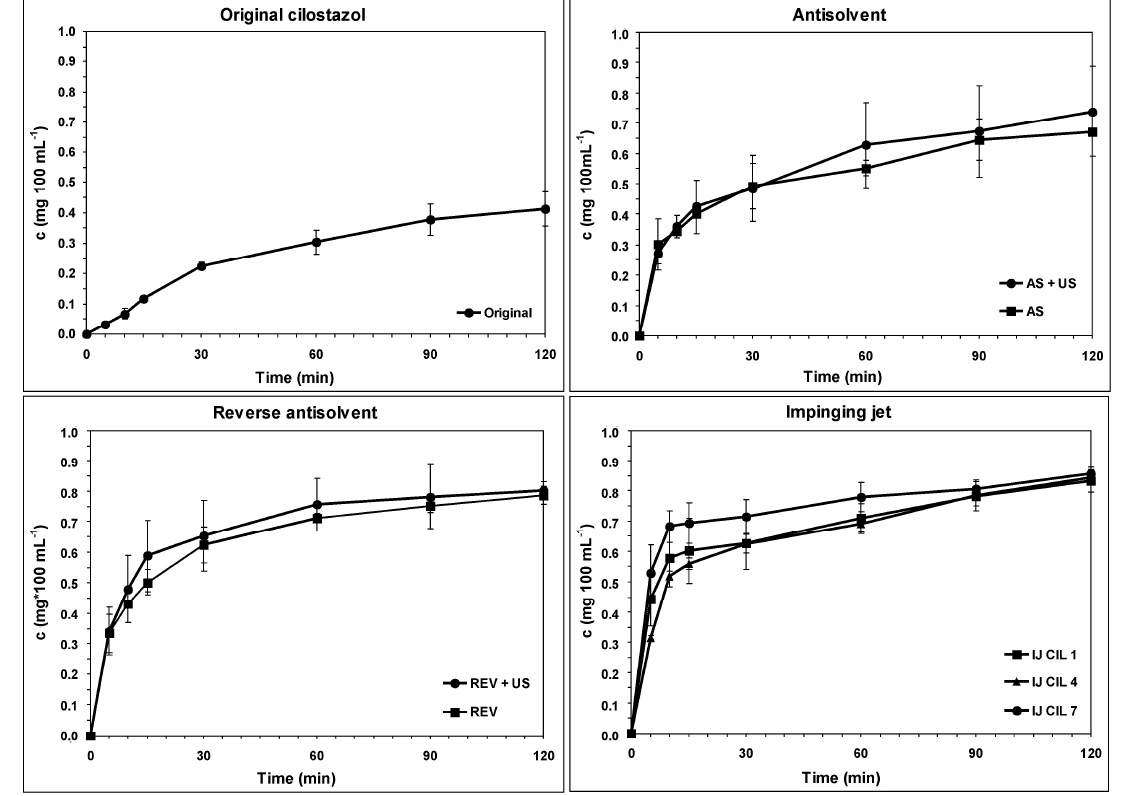
Figure 8. Dissolution rate of the crystallized